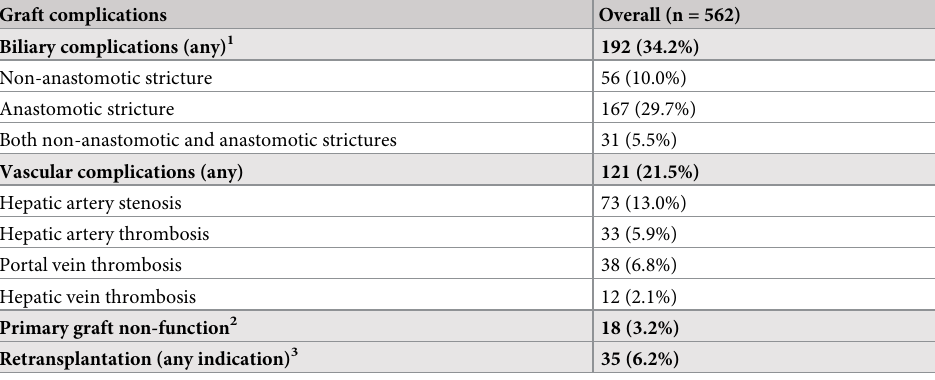
Table 2. Graft complications up to 1 year after